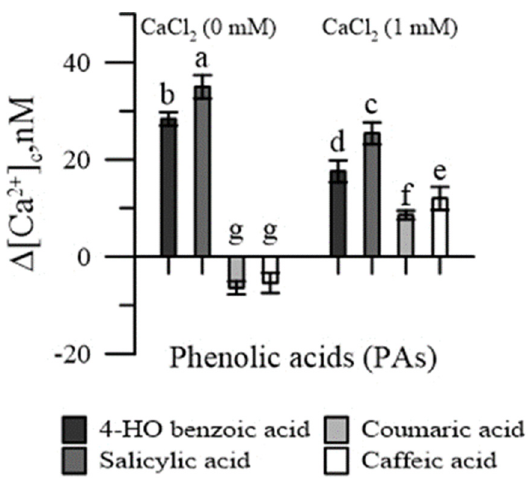
Figure 2. Effects of 4-HO benzoic, caffeic, p-coumaric and salicylic acids on cytosolic Ca 2+ of maize pollen, in Ca 2+ -free conditions and in the presence of CaCl 2 . Data are expressed as means ± SEM from five independent tests. Different letters indicate significant differences for p < 0.05.